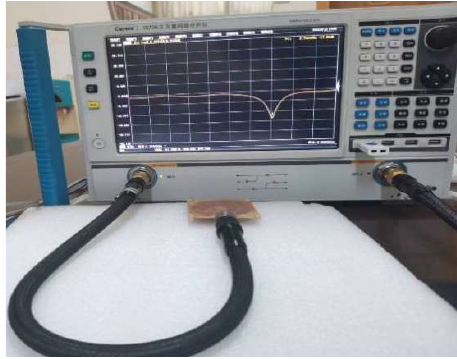
Figure 11. Diagram of measurement